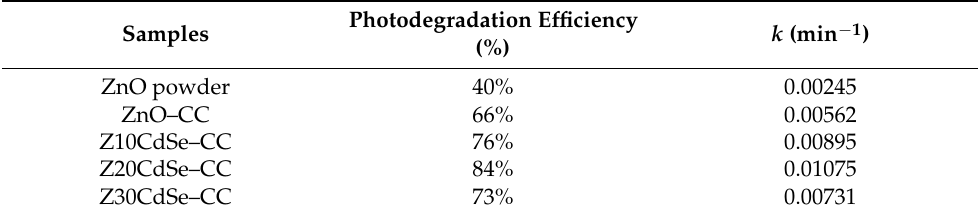
Figure 9. ( a ) MB degradation of each sample, ( b ) the time − dependent MB absorption spectrum of Z20CdSe − CC, ( c ) plot of the k values of all the samples, and ( d ) recycling test of ZnO, ZnO − CC, and Z20CdSe − CC. Table 2. Photocatalytic degradation parameters of different